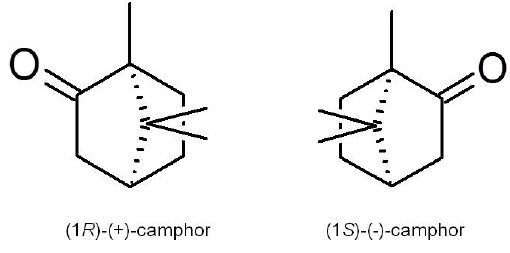
Figure 2. The chemical structure of the (1 R )-(+) and (1 S )-( − ) enantiomers of